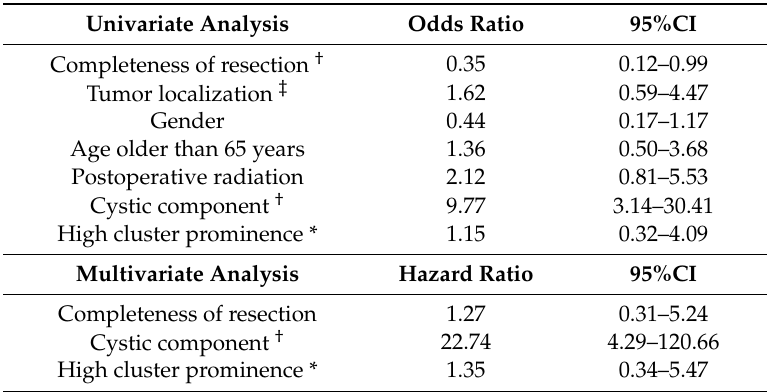
Table 3. Association of progression-free survival (PFS) with clinical, semantic and radiomic